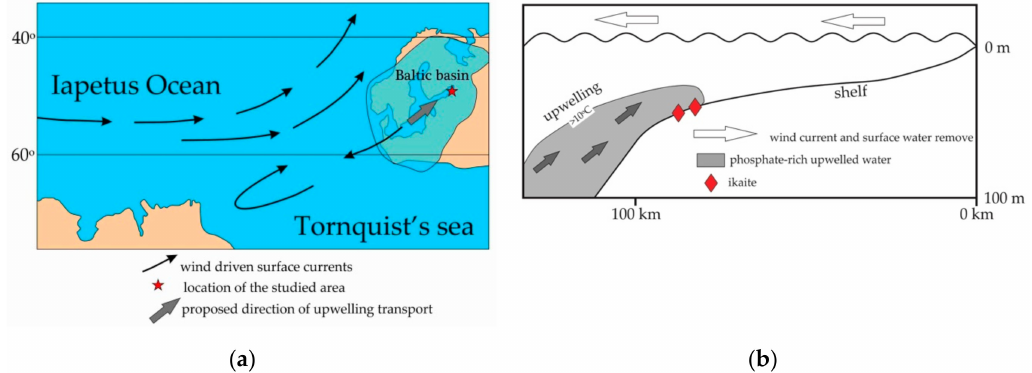
Figure 7. ( a ) Iapetus Ocean circulation model in the Tremadocian based on [59], ( b ) upwelling model for the Baltic epicontinental sea in the Early